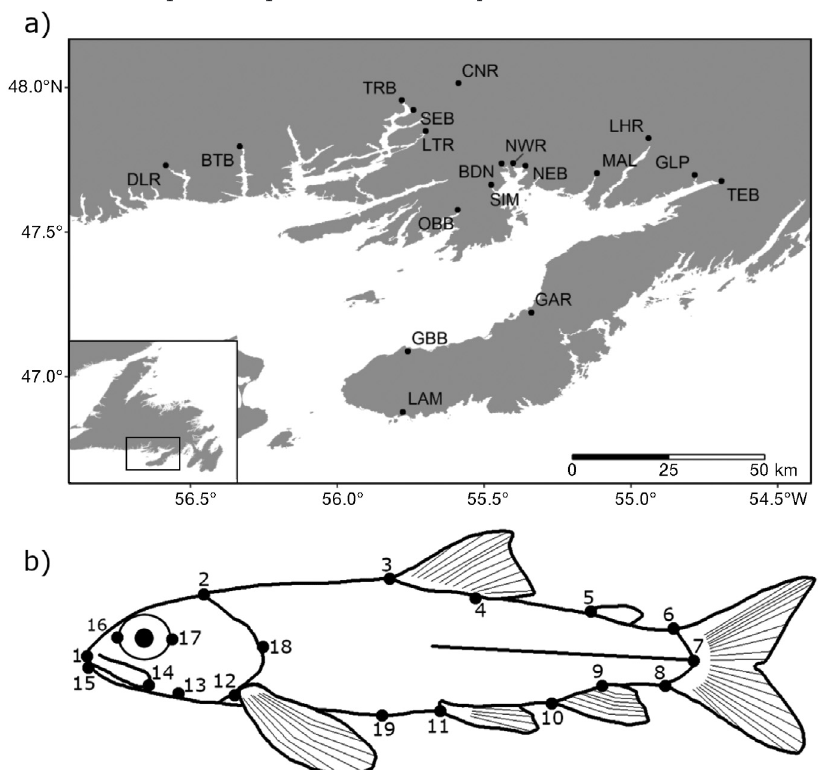
Fig. 1. (a) Sample locations in Newfoundland (Canada) rivers for 2015 and 2016 (see Table S1 in the Supplement at www.int-res.com/articles/suppl/ q014p085_supp.pdf) for details) and (b) location of 19 landmarks used for geometric morphometric analysis of Atlantic salmon (see Table S2